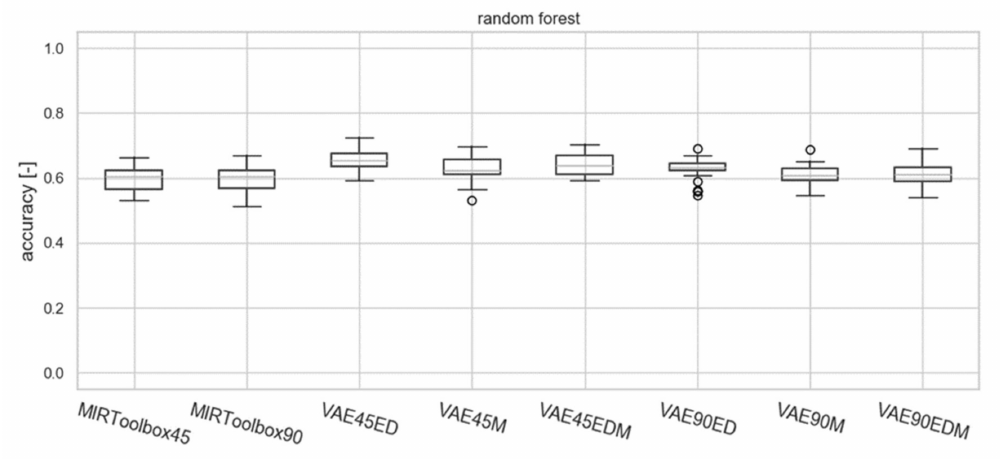
Figure 13. Accuracy obtained based for the RF classifier shown as a boxplot. Table 5. Matrix of p -values obtained for Dunn’s post hoc test associated with the RF algorithm.